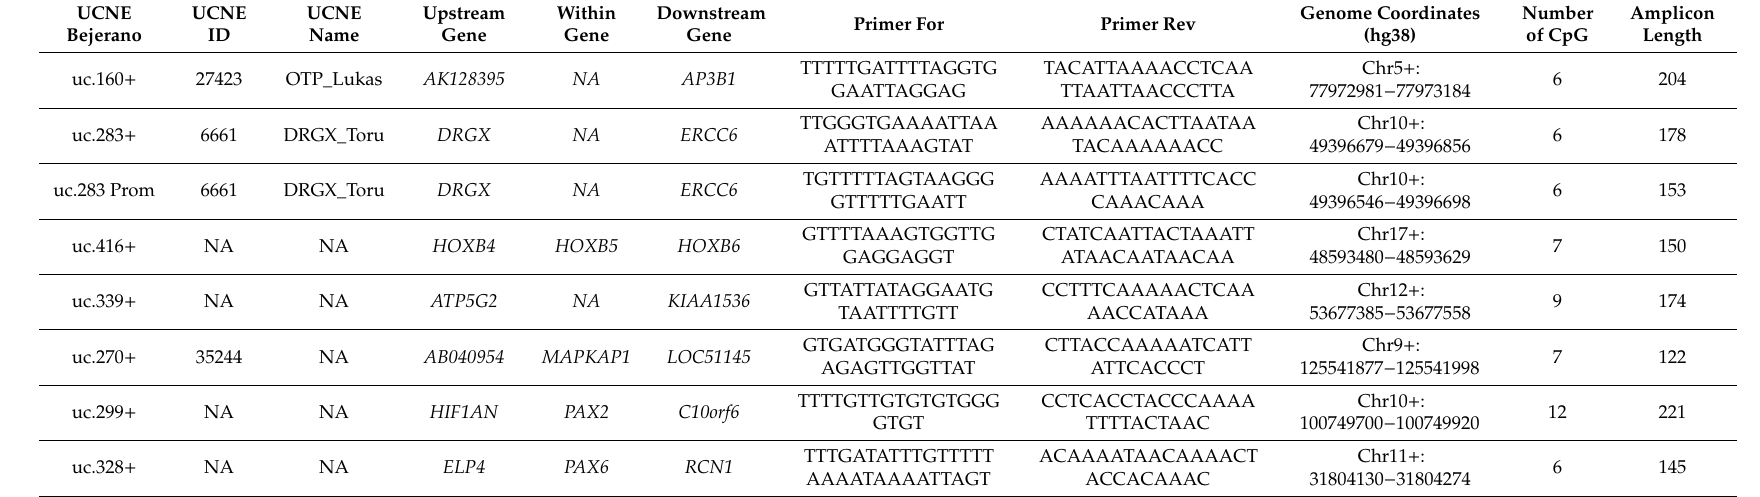
Table 2. Genomic regions investigated in this study (reference genome: hg38; gene annotations were retrieved from UCNE database [2] and from Bajerano database